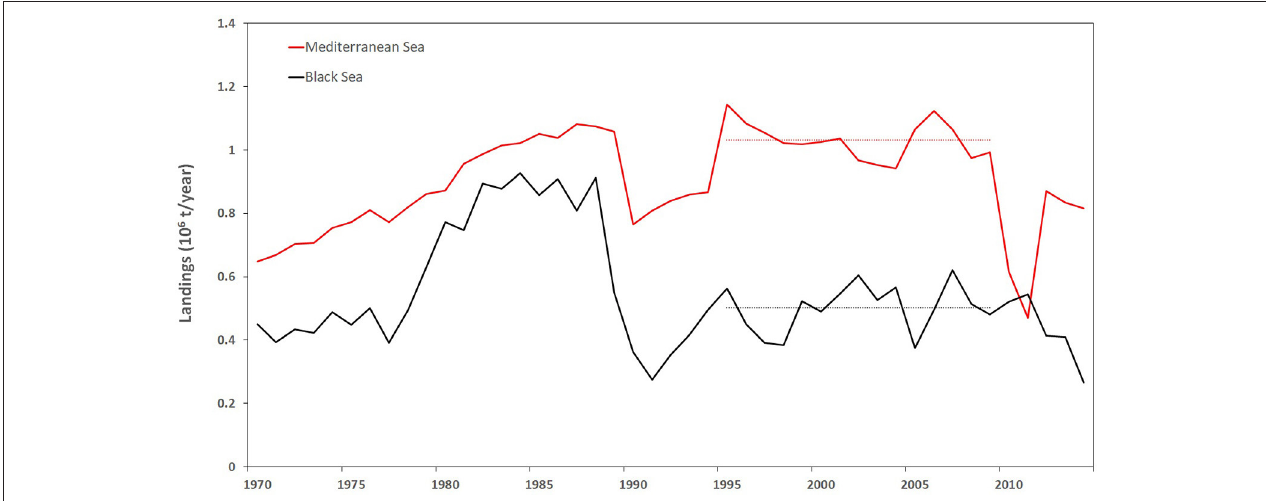
FIGURE 1 | Time series of official landings for the Mediterranean and Black Sea (data from FAO-GFCM Capture fisheries Dataset). Dotted lines indicate the average landings for the period